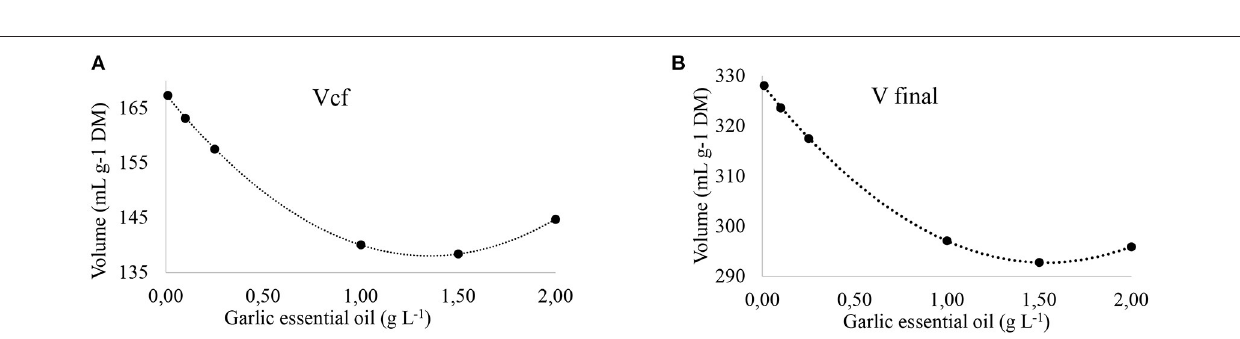
FIGURE 2 | Gas volume from fiber carbohydrate degradation (Vfc) in mL g − 1 of DM and final gas volume from both non-fiber and fiber carbohydrate degradation (Vfinal) for diets containing different doses of garlic essential oil. (A) y = 15.92180x 2 – 4312384x + 167.29801; Minimum point: 1.35; P : 0.0012; R 2 : 0.13; (B) y = 14.86581x 2 – 45.81775x + 328.07523; Minimum point: 1.54; P : 0.0012; R 2 : 0.10; P , Probability; R 2 , Determination coefficient.